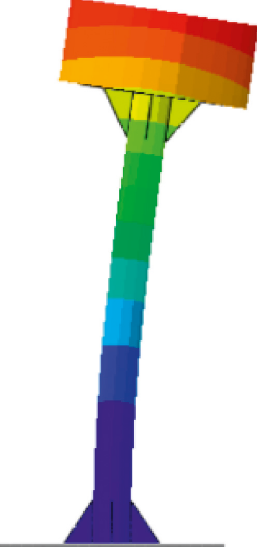
Figure 15: First-order mode of model I. Table 10: Comparison of fundamental frequency between test and simulation.